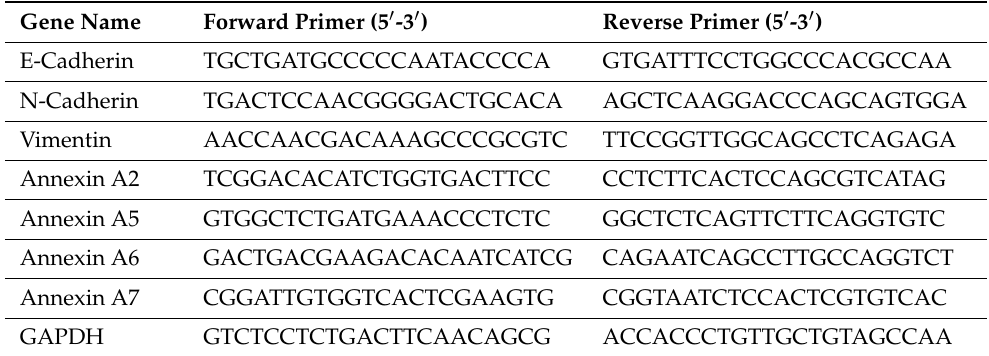
Table 1. The sequences of primers for